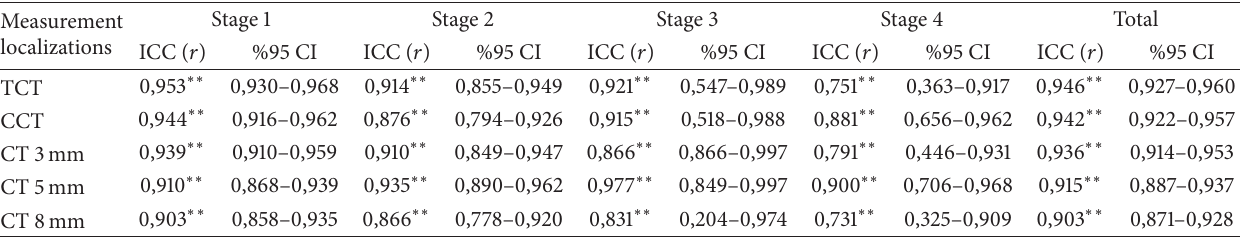
Table 3: Degree of correlation between measurements of two devices at different stages of the keratoconus.